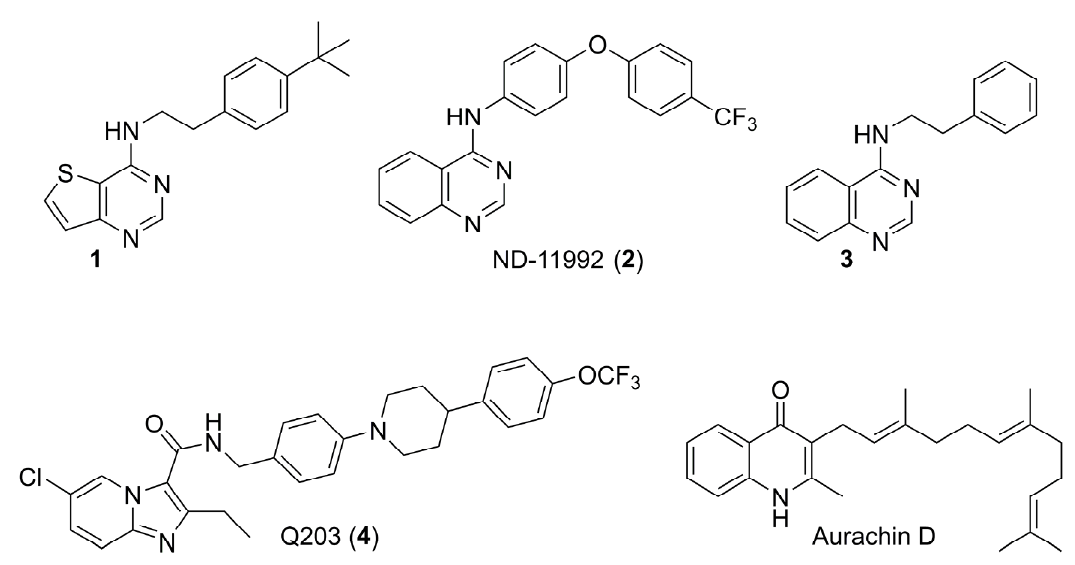
Figure 1. Known synthetically accessible small molecule cyt- bd inhibitors: thieno[3,2- d ]pyrimidin-4-amine ( 1 ) [13], ND- 11992 ( 2 ) [12], and N -phenethylquinazolin-4-amine ( 3 ) screening hit. The selective cyt- bcc:aa 3 inhibitor Q203 ( 4 ) [10] and natural cyt- bd inhibitor aurachin D [7].